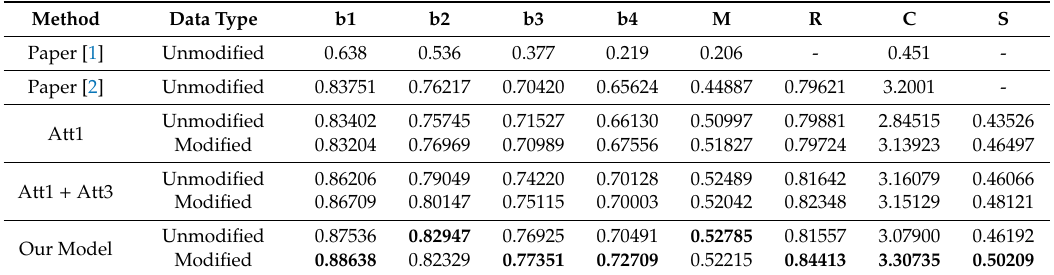
Table 4. The comparison of di ff erent methods on the unmodified and modified datasets of UCM. The bold value is the highest score.